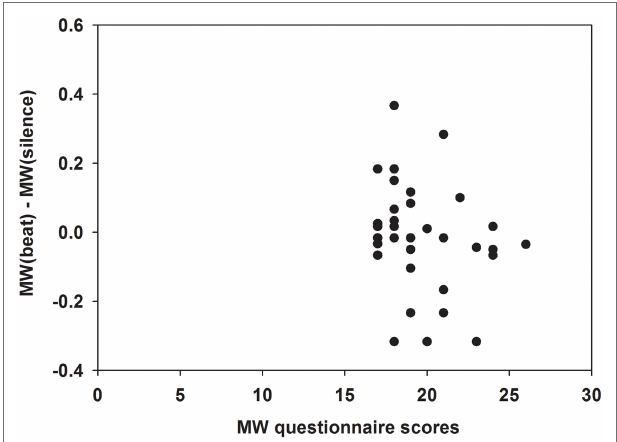
FIGURE 4 | Dependence of differences in MW propensities during monaural beats versus silence on MW scores. Differences in MW propensities during monaural beats versus silence [i.e., MW(beat)—MW(silence)] in the overall group ( n = 34). Differences in MW propensities were negatively correlated with questionnaire-based MW scores (Spearman’s correlation: ρ = − 0.322; p = 0.063).